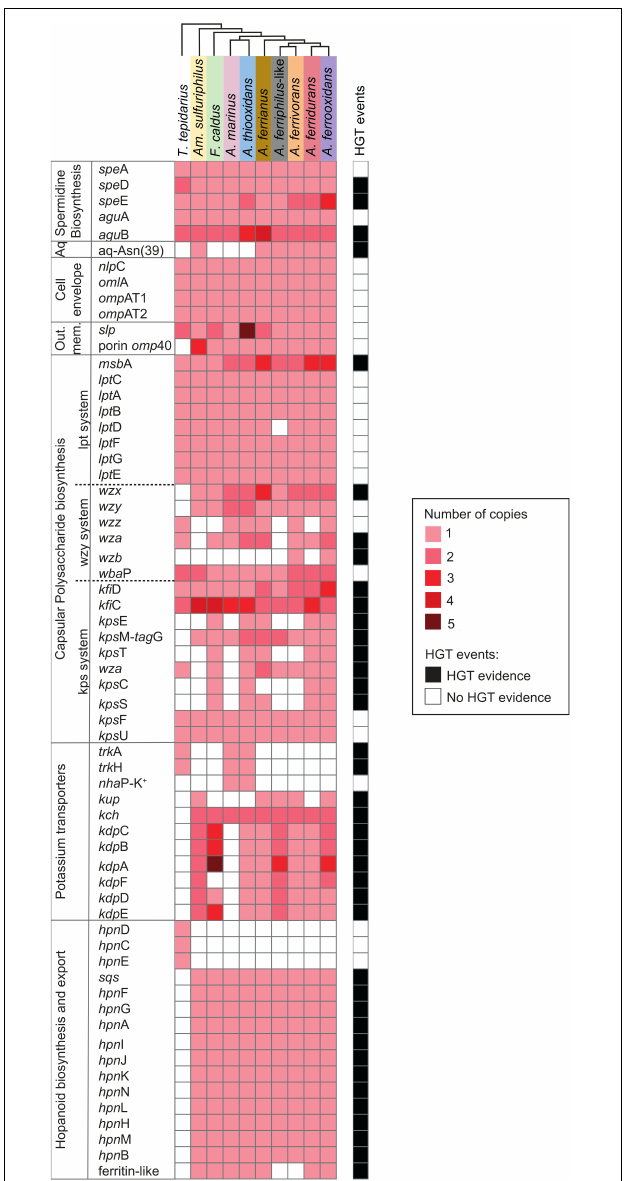
FIGURE 2 | Heatmap of presence (red) and absence (white) of genes involved in the first line of Acidithiobacillia class acid resistance including spermidine biosynthesis; aquaporine (Aq) with an asparagine residue (Asn39); cell envelope; outer membrane proteins (Out. mem.); capsular polysaccharide biosynthesis with pathways Lpt-, Wzy-, and Kps-systems; potassium transporters; and hopanoid biosynthesis plus export. The color intensity represents higher gene copy number per genome. The presence of genes (black; right-hand side) denotes HGT events by genome context with mobile genetic elements, phylogenetic trees, or if it was signaled as part of an HGT event by HGTector (Zhu et al., 2014). T. tepidarius , Thermithiobacillus tepidarius DSM 3134; Am. Sulfuriphilus , Ambacidithiobacillus sulfuriphilus CJ-2; F. caldus , Fervidacidithiobacillus caldus ATCC 51756; A. marinus , Acidithiobacillus marinus SH; A. thiooxidans , A. thiooxidans ATCC 19377; A. ferrianus , A. ferrianus MG; A. ferriphilus -like, A. ferriphilus -like BY0502; A. ferrivorans , A. ferrivorans SS3; A. ferridurans , A. ferridurans JCM 18981; and A. ferrooxidans , A. ferrooxidans ATCC 23270 (shaded colors correspond to those used in Figure 1